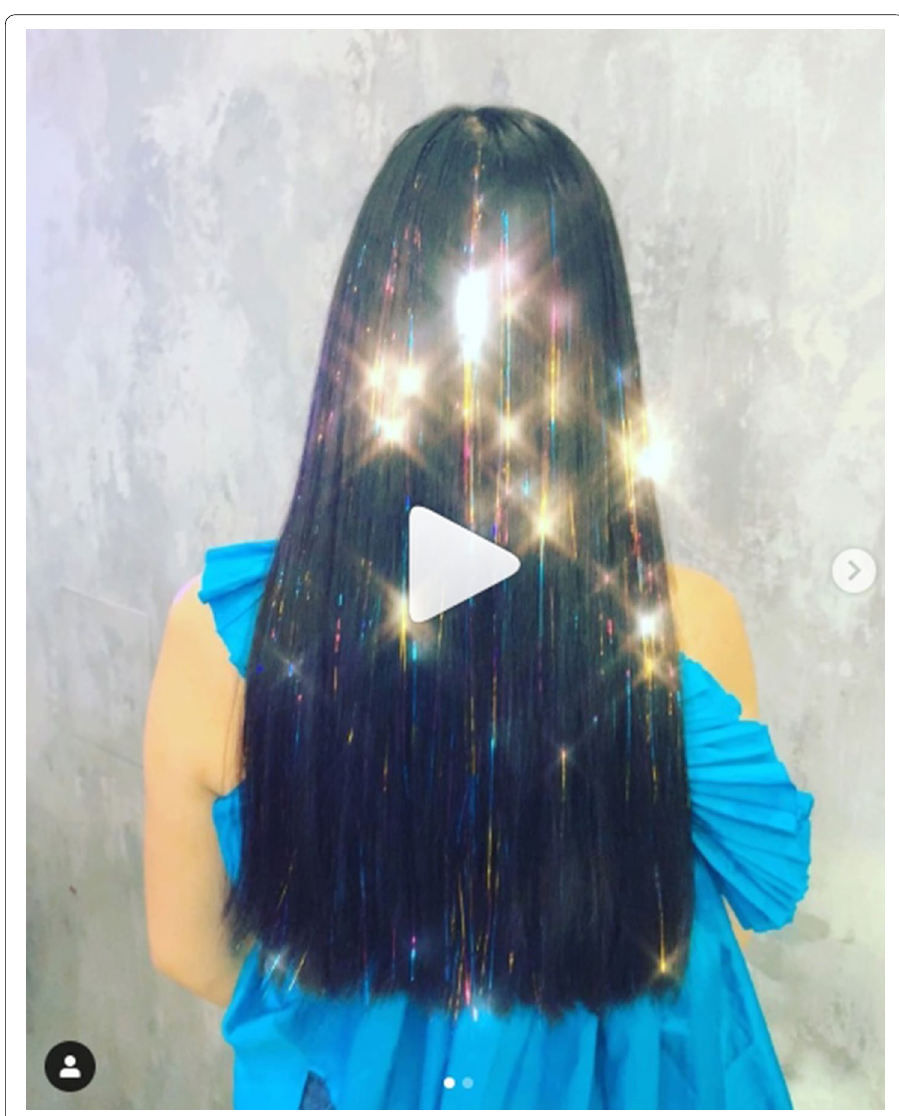
Fig. 12 Hair tinsel magic. https ://www.insta gram.com/p/BxvI3 kfHKZ K/. Accessed 22 September